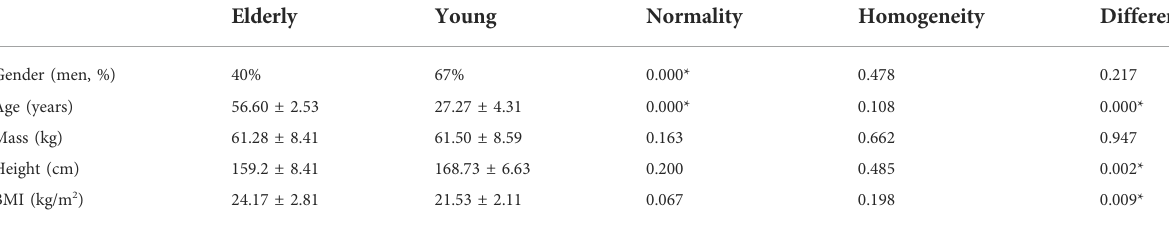
TABLE 1 Comparison of characteristics between elderly and young groups.